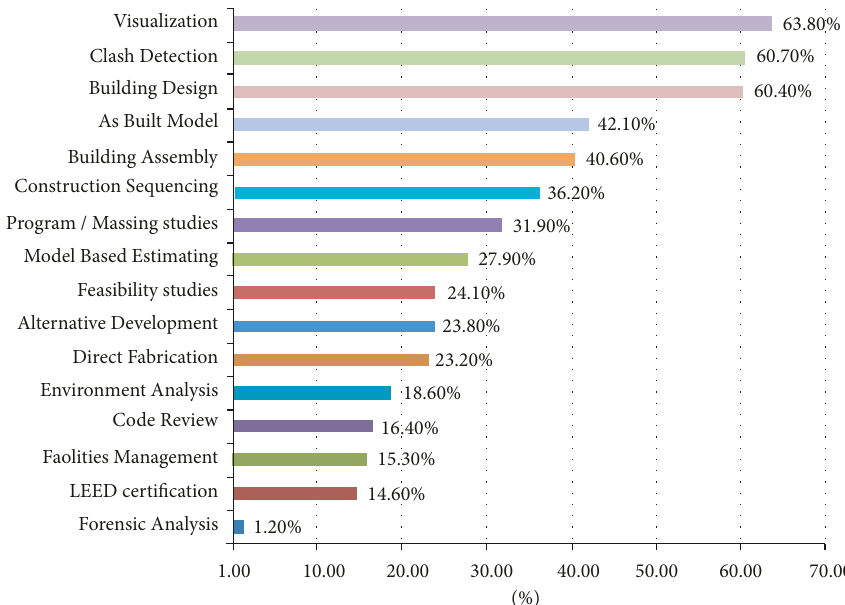
Figure 9: Percentage utilization of BIM in various fields of the construction industry [33,